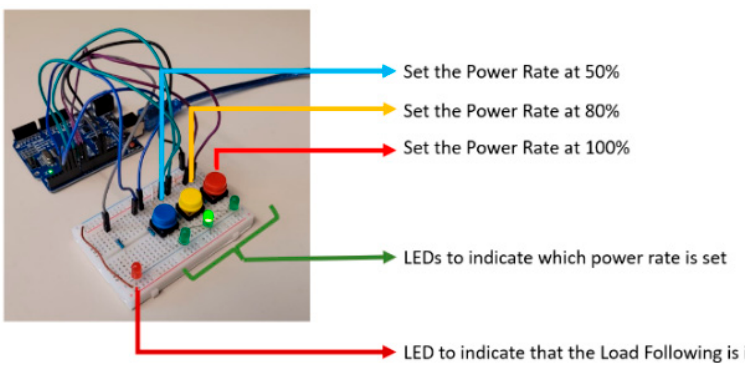
Figure 18. Hardware implementation—Arduino UNO.